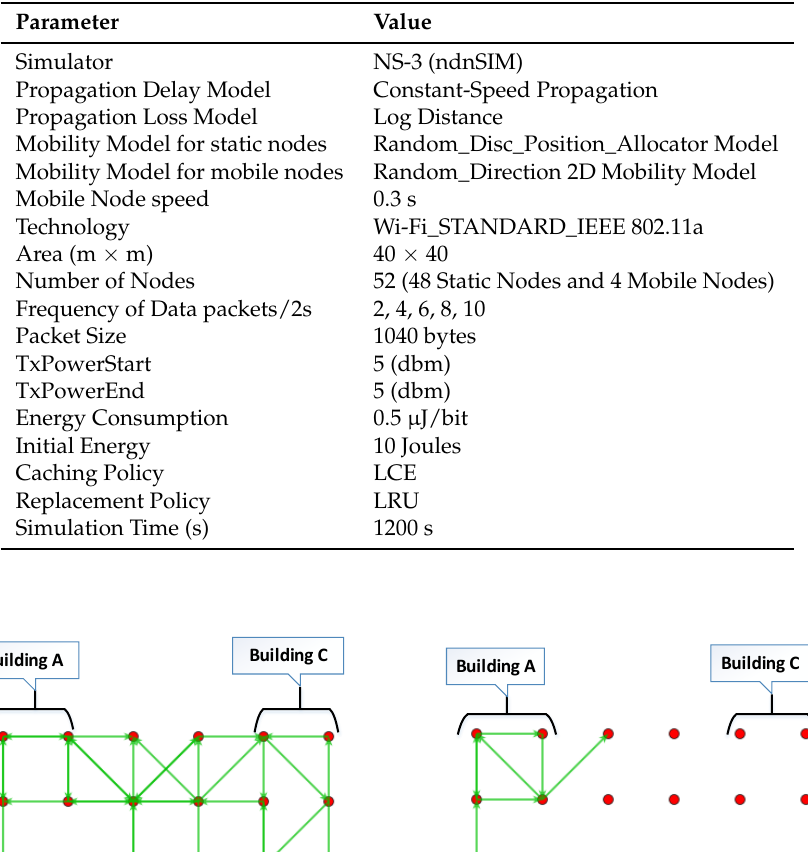
Table 1. Simulation Parameters for Building Scenario.